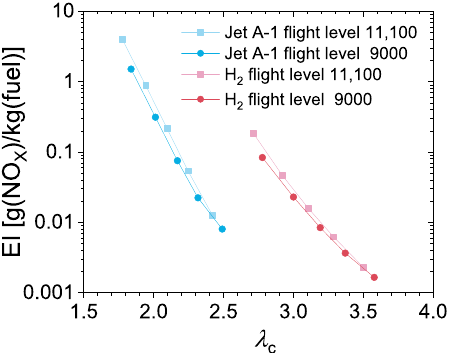
Figure 7. Reactor network results of NO x emission index dependency on with the variation of λ c